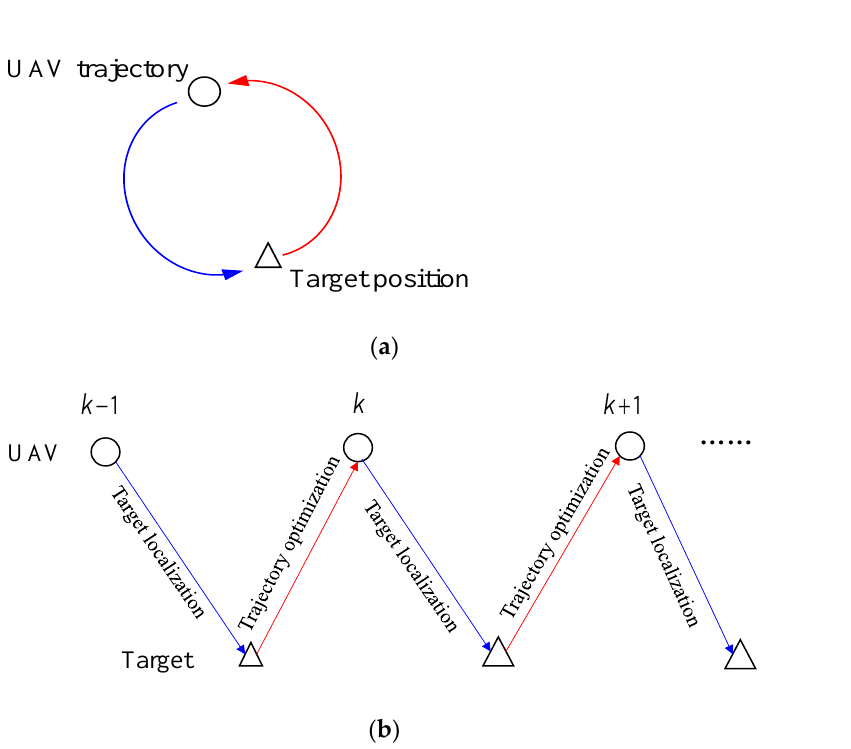
Figure 4. Simultaneous target localization and trajectory optimization. ( a ) Coupled problem. ( b ) Decoupled problem.